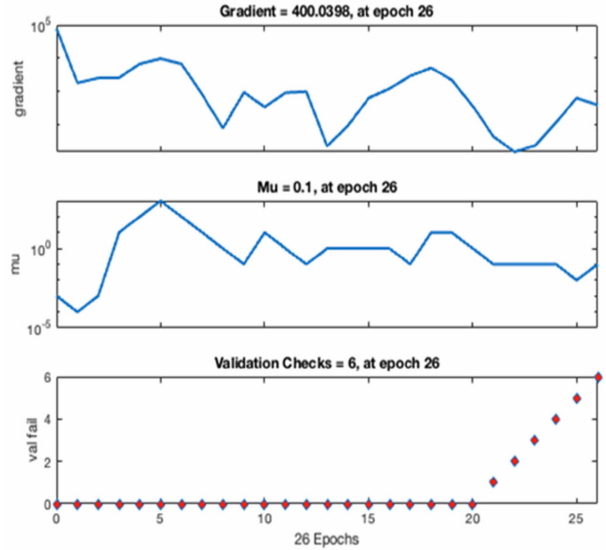
Figure 4. Validation in the training phase of model one.